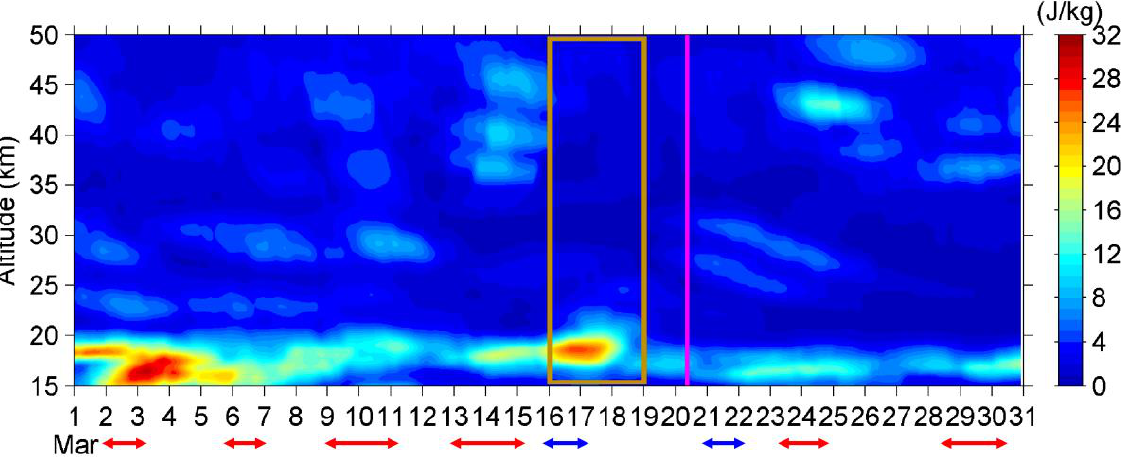
Figure 11. Same as in Figure 8, but for the second EQ.